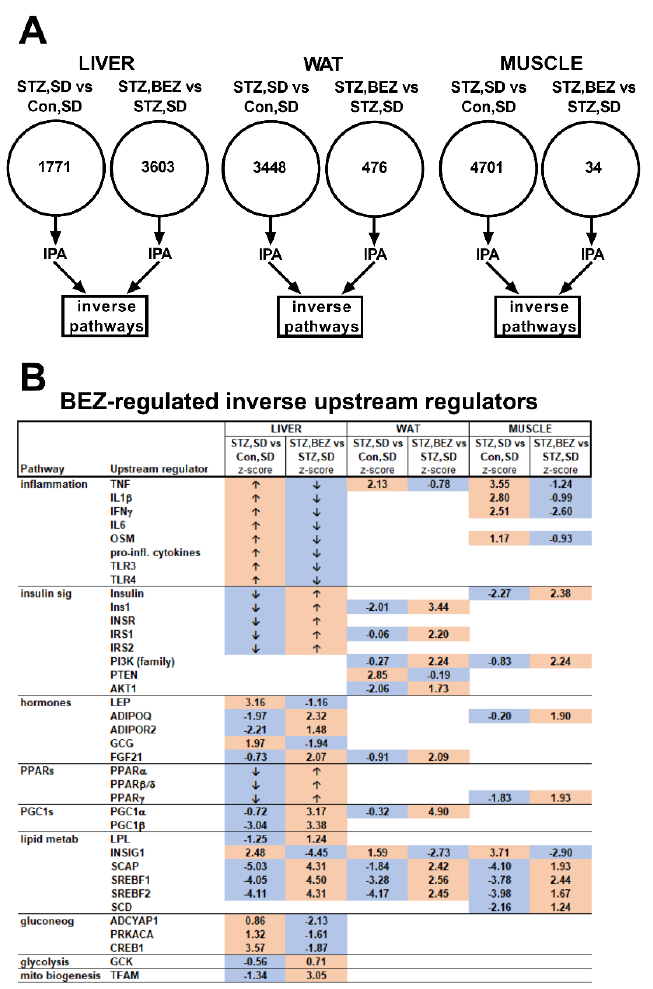
Figure 1. Microarray analysis in liver, white adipose tissue (WAT) and skeletal muscle samples of BEZ-treated STZ mice. ( A ) Schematic representation of microarray results. The numbers given in the circles depict the number of significantly differently expressed genes comparing STZ, SD vs. Con, SD as well as STZ, BEZ vs. STZ, SD, respectively. The statistical analysis was performed using significance analysis of microarrays algorithm with FDR of 10%. Upstream regulator tool of ingenuity pathway analysis (IPA) was applied on these significant genes with the focus on inverse pathways, n = 5–7. ( B ) Inverse upstream regulator pathways of IPA analysis between STZ, SD vs. Con, SD as well as STZ, BEZ vs. STZ, SD comparisons. Numbers and arrows denote z-scores of upstream regulator IPA pathways. The z-scores > 0 represent activated, whereas z-scores < 0 represent inhibited pathways. Values > 2 or < − 2 indicate significant results, whereas values between − 2 and 2 depict trends. “ ↑ ” or “ ↓ ” arrows show activated or inhibited upstream regulators described in [1] and the publisher granted permission to reuse the data. Orange or blue colors indicate activated or inhibited pathways, respectively. The theoretical order of the identified pathways, which are possibly involved in insulin sensitivity, glucose and lipid metabolism, are shown in Figure 2. Abbreviations: